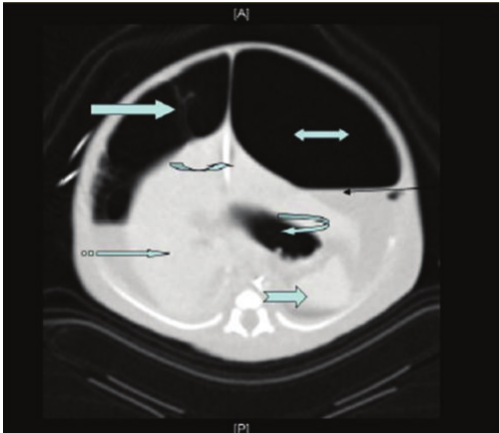
Figure 3: Abdominal CT scan image: showing abundant intraperi- toneal space (biheaded block arrow) and fluid levels (black line arrow) with multiple thick septation (right block arrow) noted mainly at the right hypochondrium. Umbilical vein catheter (curved right arrow), spleen (notched right block arrow), stomach (curved left arrow), and liver (striped right block arrow) were